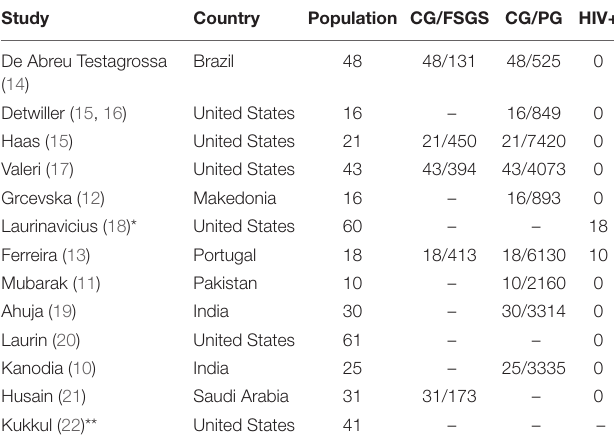
TABLE 1 | CG prevalence in populational